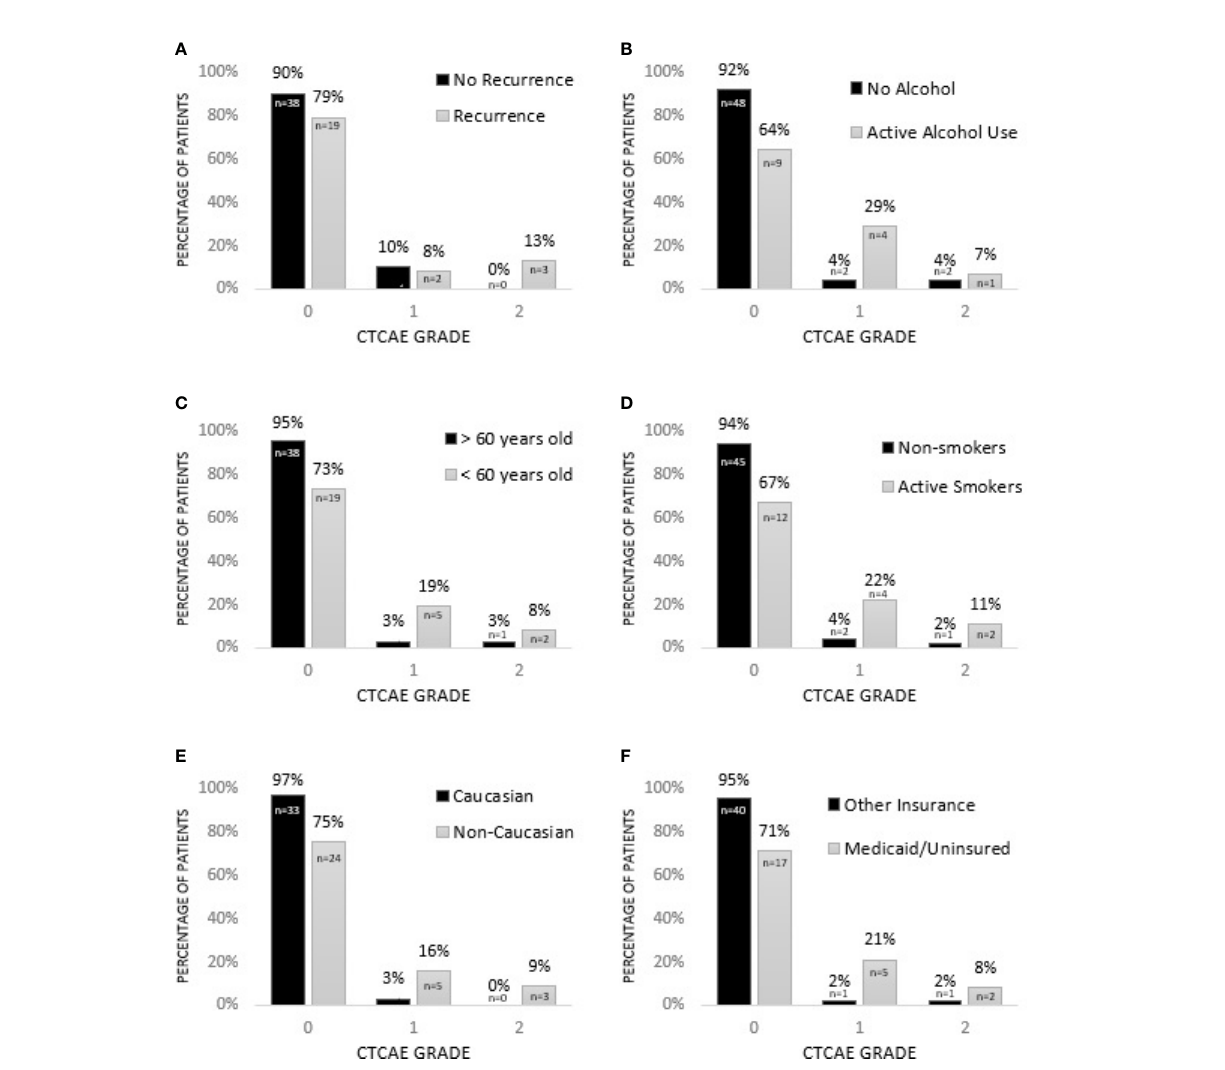
Patients (%) with CTCAE Symptom at 5 - 15 Weeks